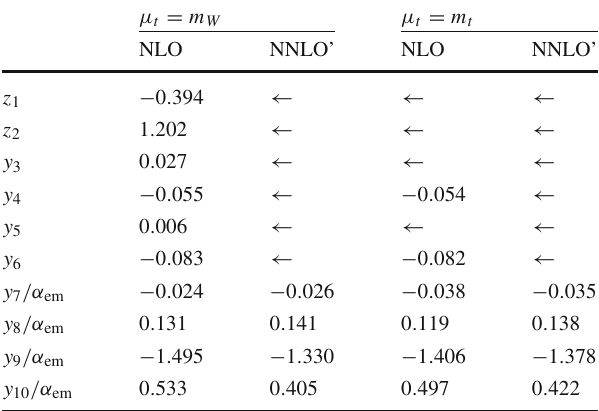
Table 5 The (cid:8) S = 1 Wilson coefficients at μ = m c = 1 . 3GeV in the NDR-MS scheme for the renormalization scale μ W = m W and